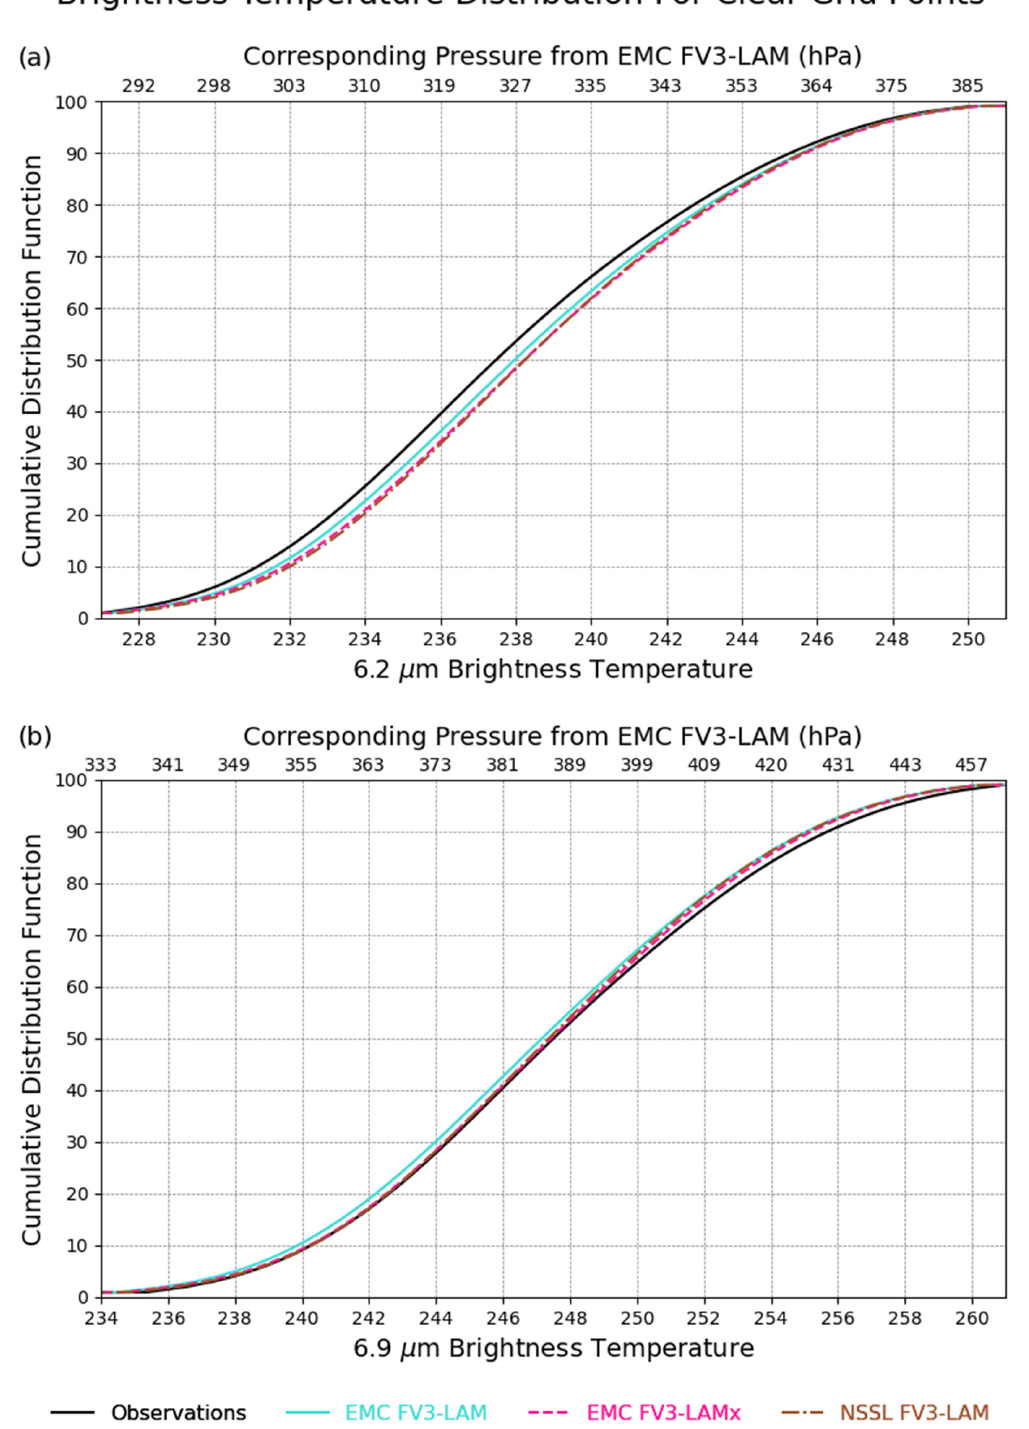
Figure 6. Cumulative distribution function of ( a ) 6.2 µ m brightness temperatures and ( b ) 6.9 µ m brightness temperatures for the 2020 HWT dataset. The corresponding pressure on the upper x -axis is the level where the atmospheric temperature reaches the given WV BT in the EMC FV3 ‐ LAM.